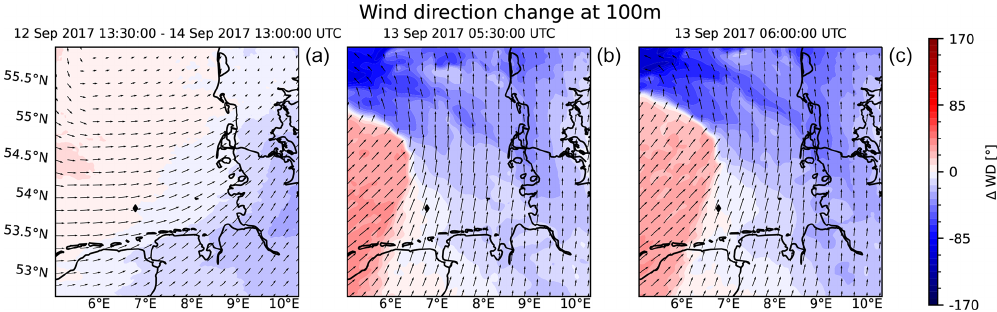
Figure 7. Wind direction changes during the passage of Cyclone Sebastian in September 2017. Panel (a) shows the median (time span of 48h) of the wind direction changes with reference to FINO1, which is marked as a black diamond. Panels (b) and (c) show snapshots of the wind field as the cold front of Sebastian passed over FINO1. The black arrows indicate the wind direction and speed. The coastline and border data originate from the Natural Earth dataset (Natural Earth, 2021).